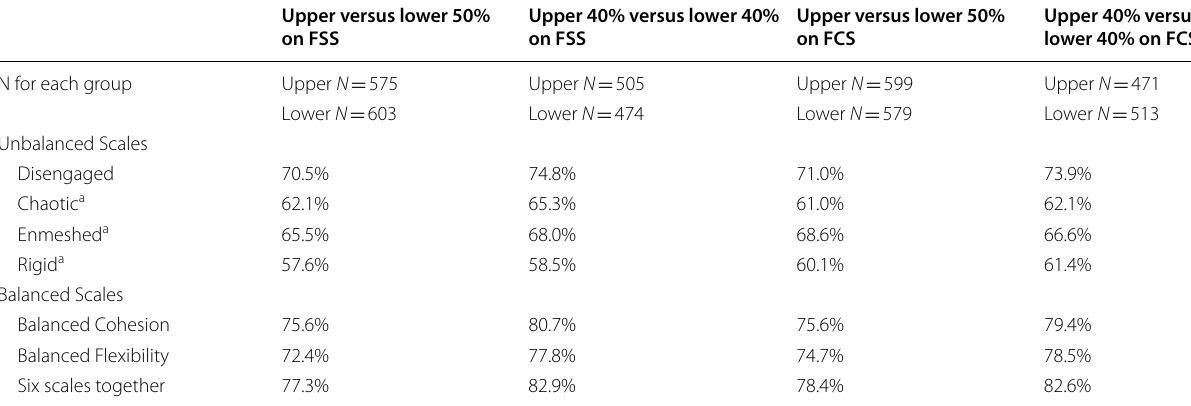
(. a )Adapted new scales, without deleted items GR 1 Upper N Non- problem Families = = GR 2 Lower N Problem Families = =